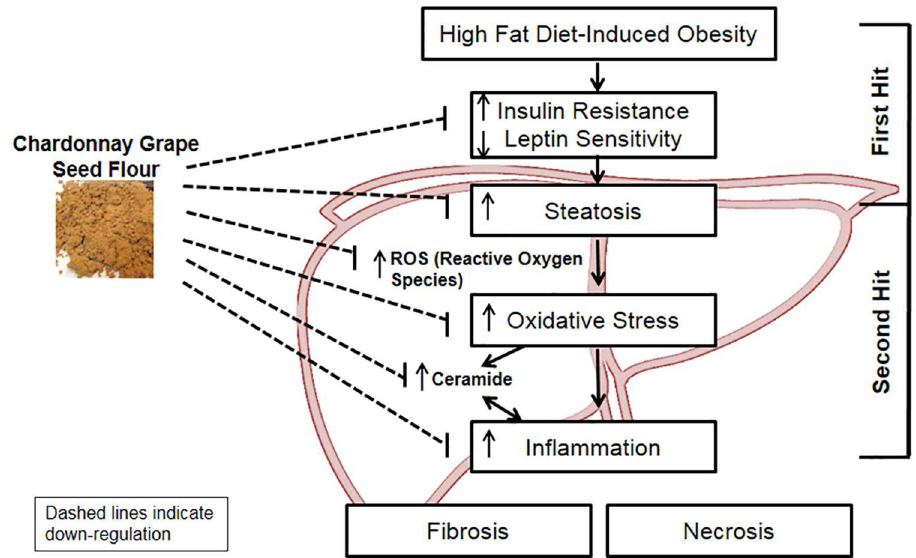
Fig 5. Proposed mechanisms by which flavonoid-rich Chardonnay grape seed flour (ChrSd) ameliorates high-fat (HF) diet-induced insulin resistance, hepatic steatosis, and nonalcoholic fatty liver disease (NAFLD). Supplementation with ChrSd lowers HF-induced insulinresistanceand hepatic steatosis and enhancesleptin sensitivity, followedby loweredoxidativestress and inflammation via reduction of ROS and ceramidesynthesis. The result is possibleameliorationof HF-inducedprogressionof NAFLD. ROS, reactive oxygen species.